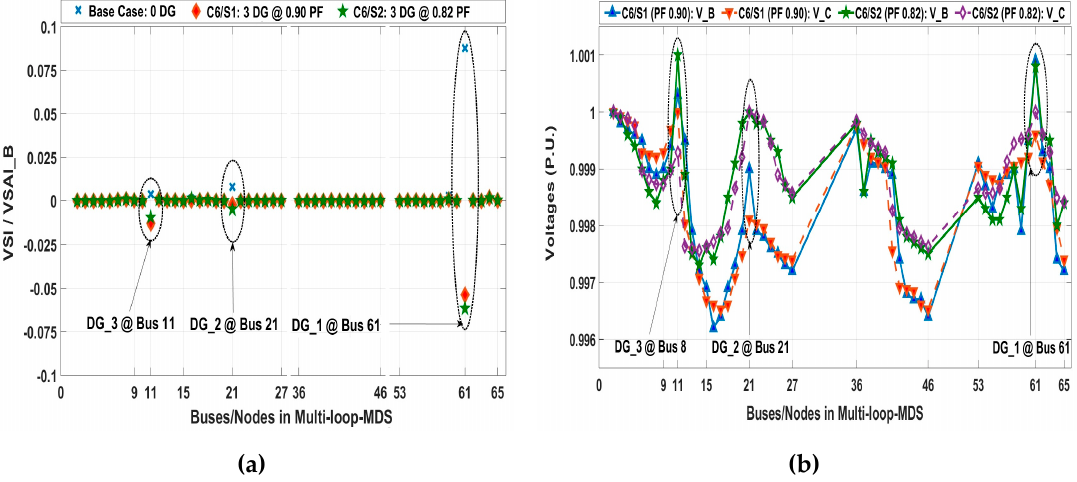
Figure 11. Case 6 for 69-bus MDS: DG (type-2) operating at 0.90 ± 3% PF ( a ) VSAI_B trend, ( b ) V_B profile trend as feasible solution of VSAI_B and calculated V_C profiles.